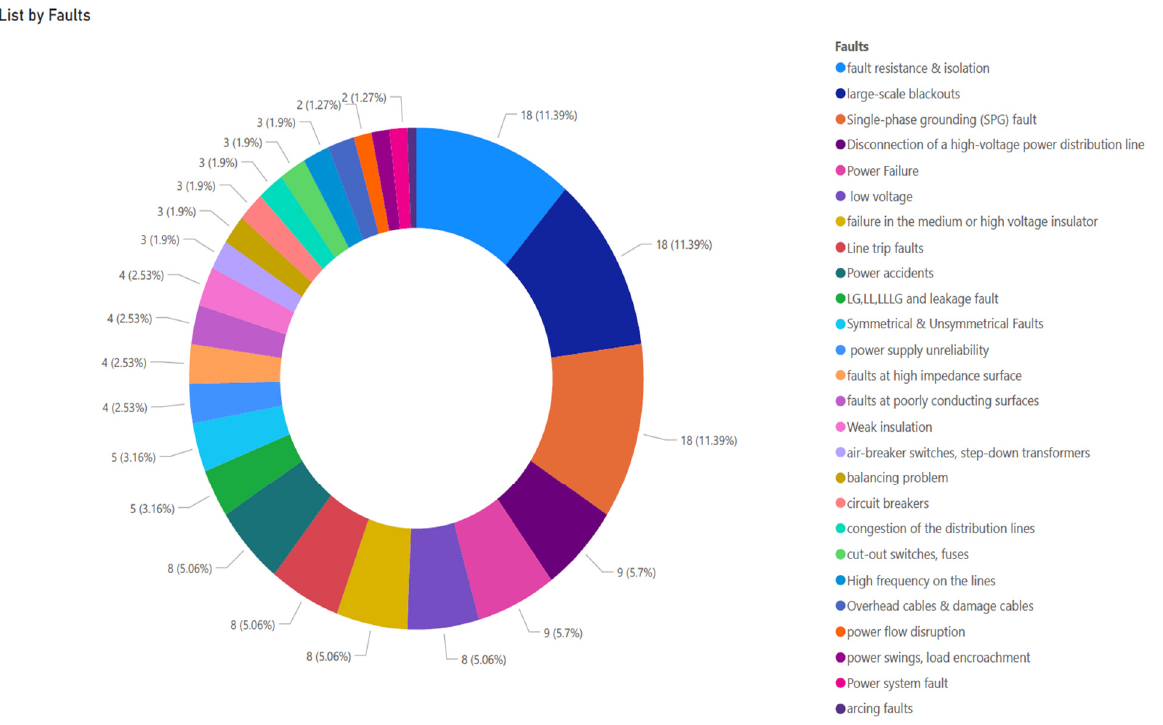
Figure 3. Causes of faults.